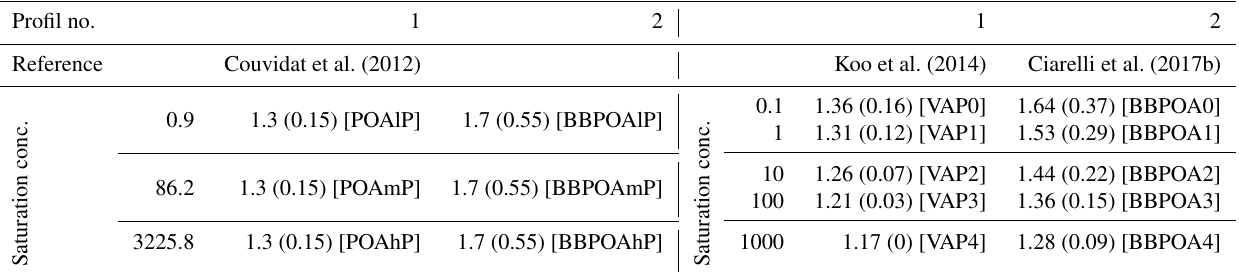
Table 3. Summary of the OM:OC (and O:C) ratio of the primary I/S-VOC surrogates. Saturation concentrations are expressed in µgm − 3 . For each saturation concentration and OM:OC ratio, the name of the associated primary surrogate is in square brackets. Profil